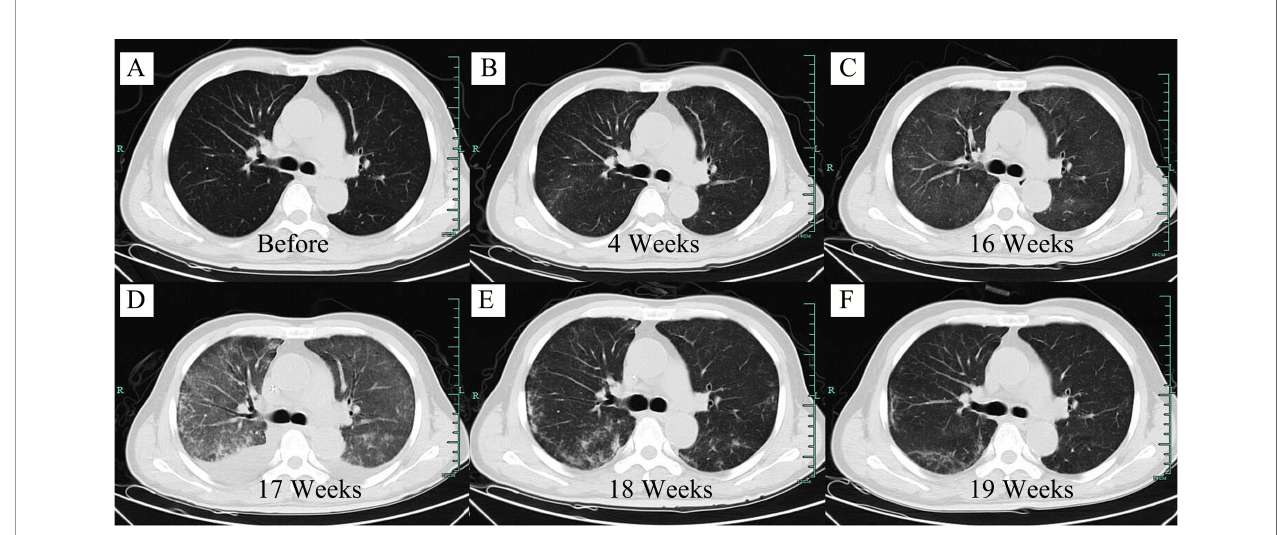
FIGURE 2 | Axial computed tomography (CT) scan of the lung at different time points. (A) Screening period before CAR-T cell infusion. (B) 4 weeks after CAR-T cell infusion. (C) 16 weeks after CAR-T cell infusion. (D) 17 weeks after CAR-T cell infusion. (E) 18 weeks after CAR-T cell infusion. (F) 19 weeks after CAR-T cell